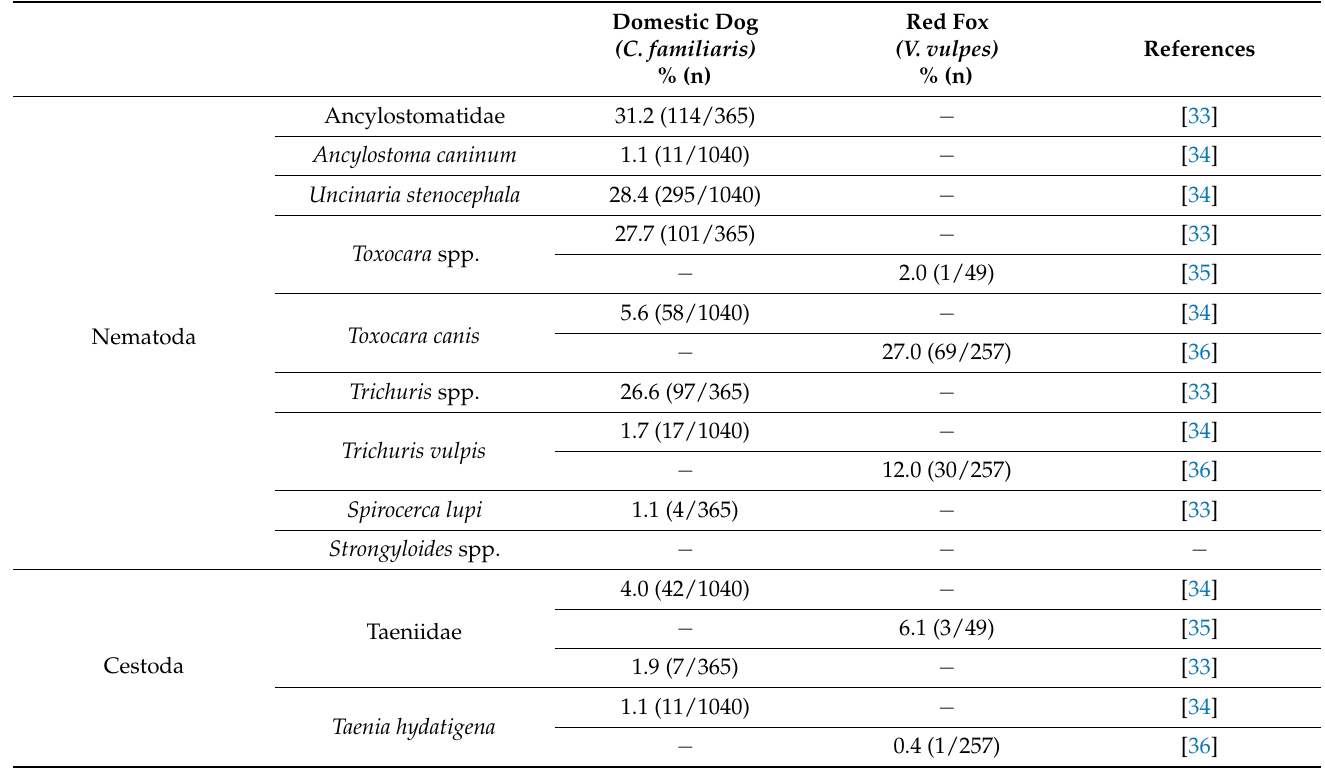
Table 5. Prevalence (%) of parasitic agents with zoonotic potential reported in domestic dogs ( Canis familiaris ) and red foxes ( Vulpes vulpes ) in Spain